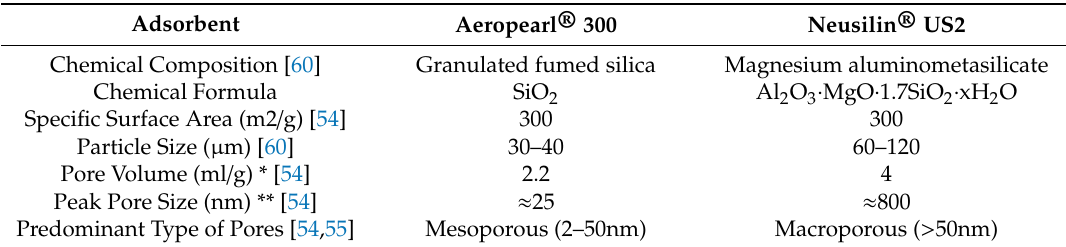
Table 5. The chemical nature and particle properties of Aeroperl 300 and Neusilin US2.